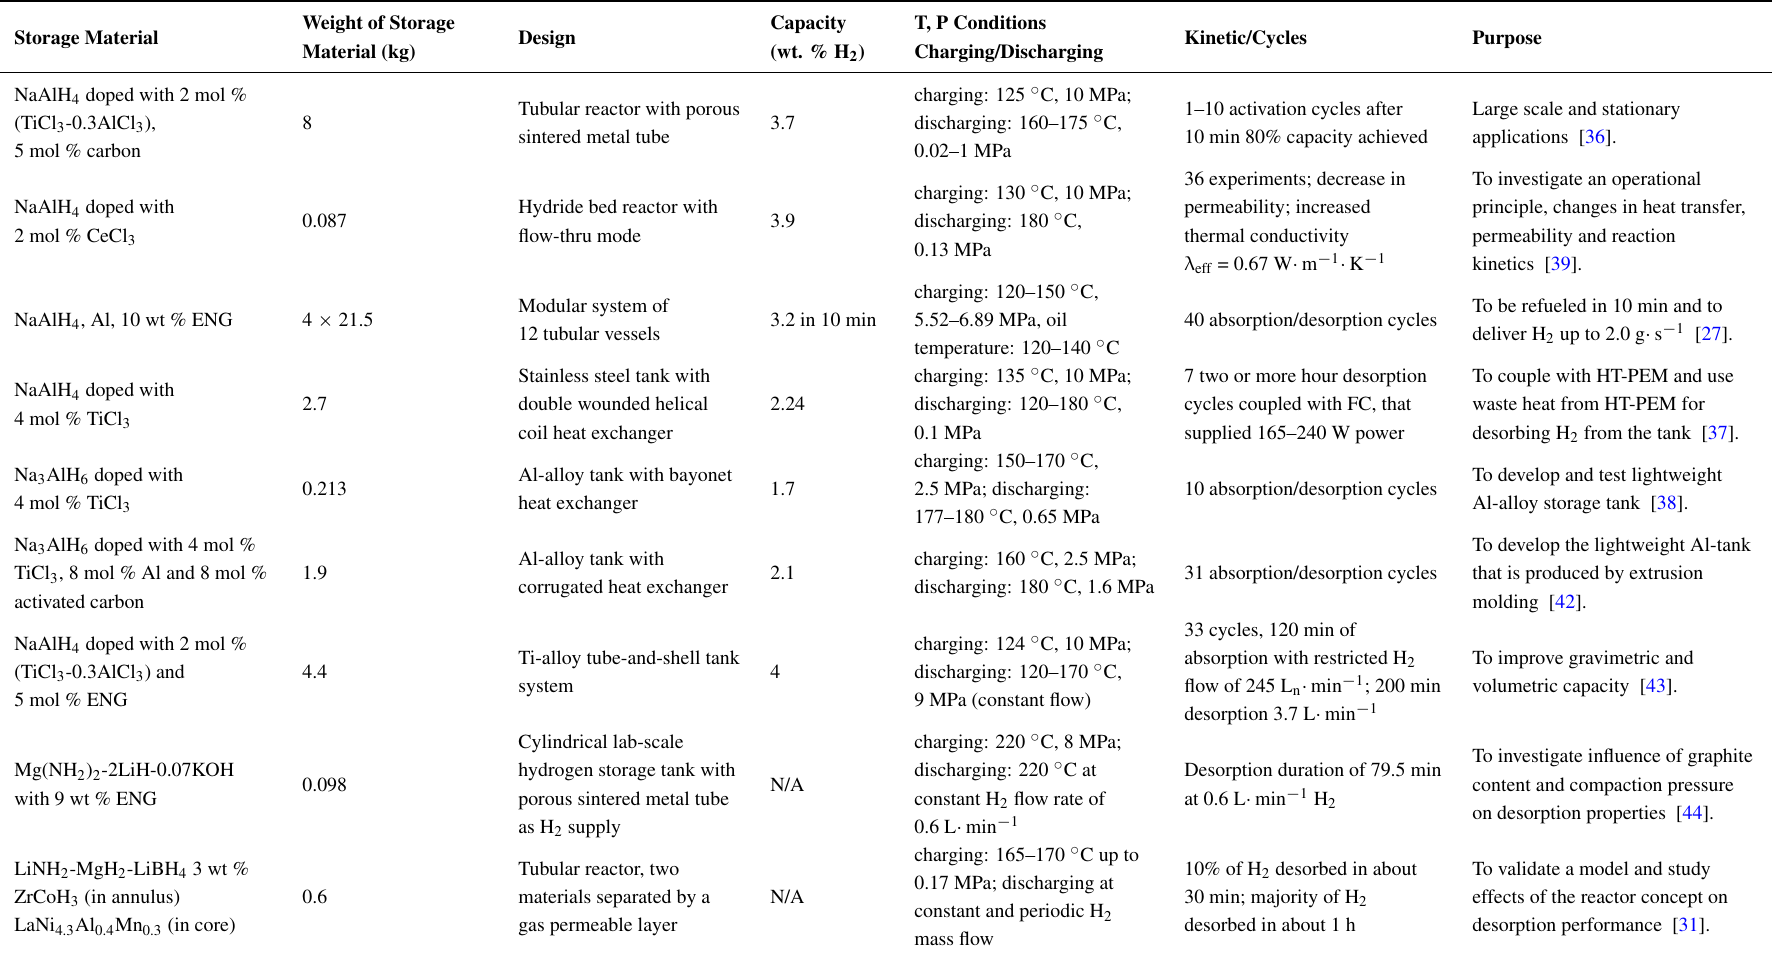
Table 3. Summary of the developed hydrogen storage